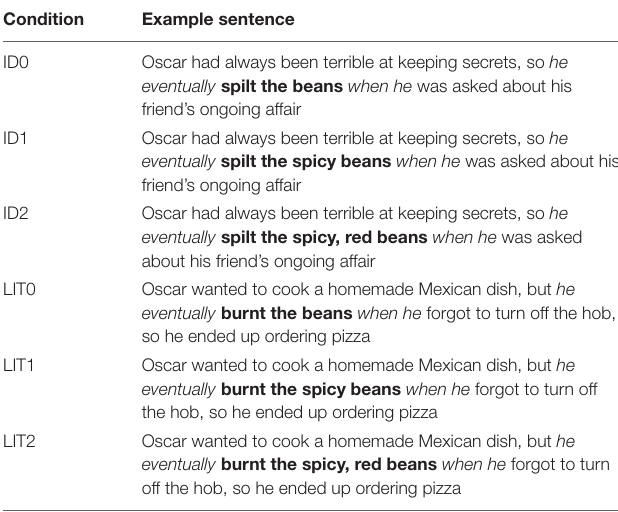
The phrases of interest (in bold) are split across Adjective Condition with ID0 and LIT0 denoting an idiomatic and literal phrase without adjectives, ID1 and LIT1 denoting an idiomatic and literal phrase with 1 adjective, and ID2 and LIT2 denoting an idiomatic and literal phrase with 2 adjectives,